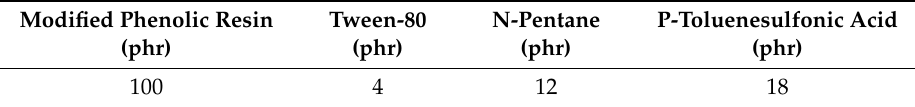
Table 1. Modified phenolic foam